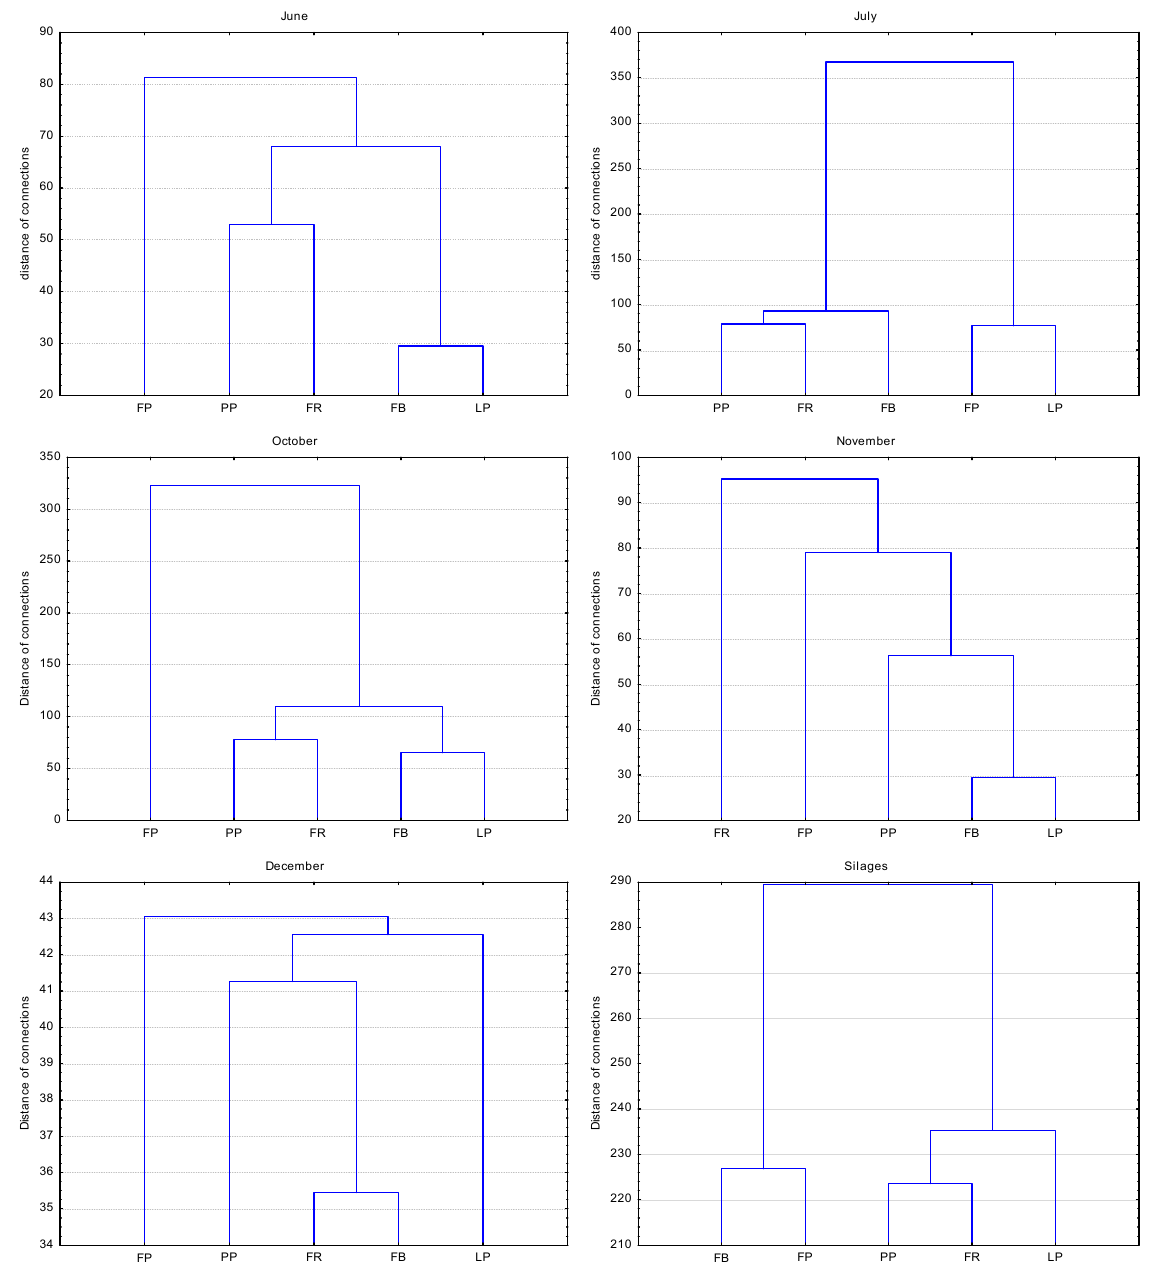
Figure 2. Cluster analysis of evaluated species (Euclidean distance),